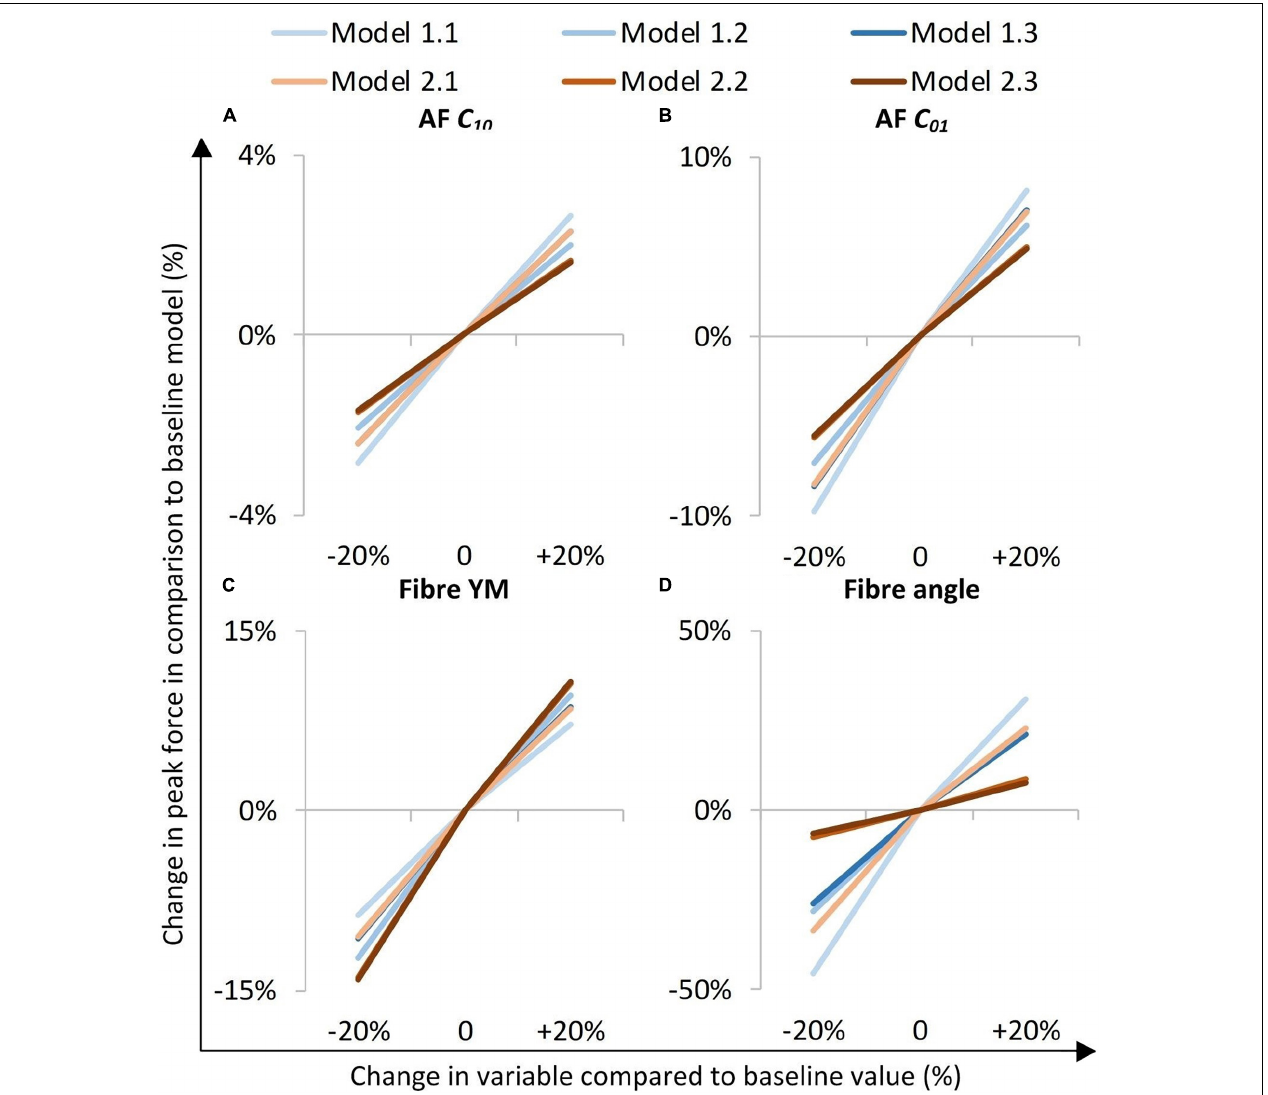
FIGURE 6 | Sensitivity study overview. The y-axis represents a percentage change in peak axial force from that obtained in the initial baseline run of each of the six models when a parameter was changed by ± 20%. (A,B) are AF ground matrix material properties, (C,D) are AF fibre